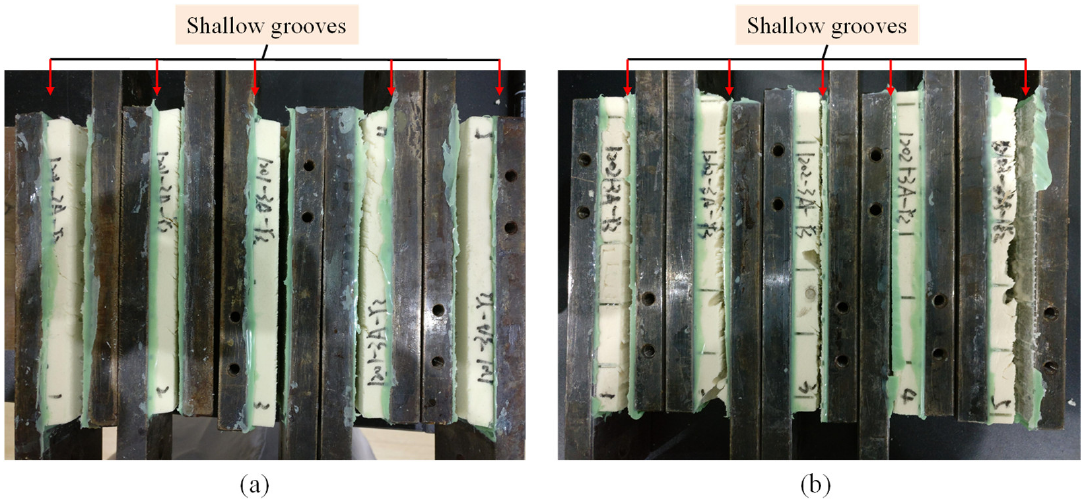
Figure 9. The shear properties of the plain, GP, and GPC cores: ( a ) modulus and ( b ) strength.